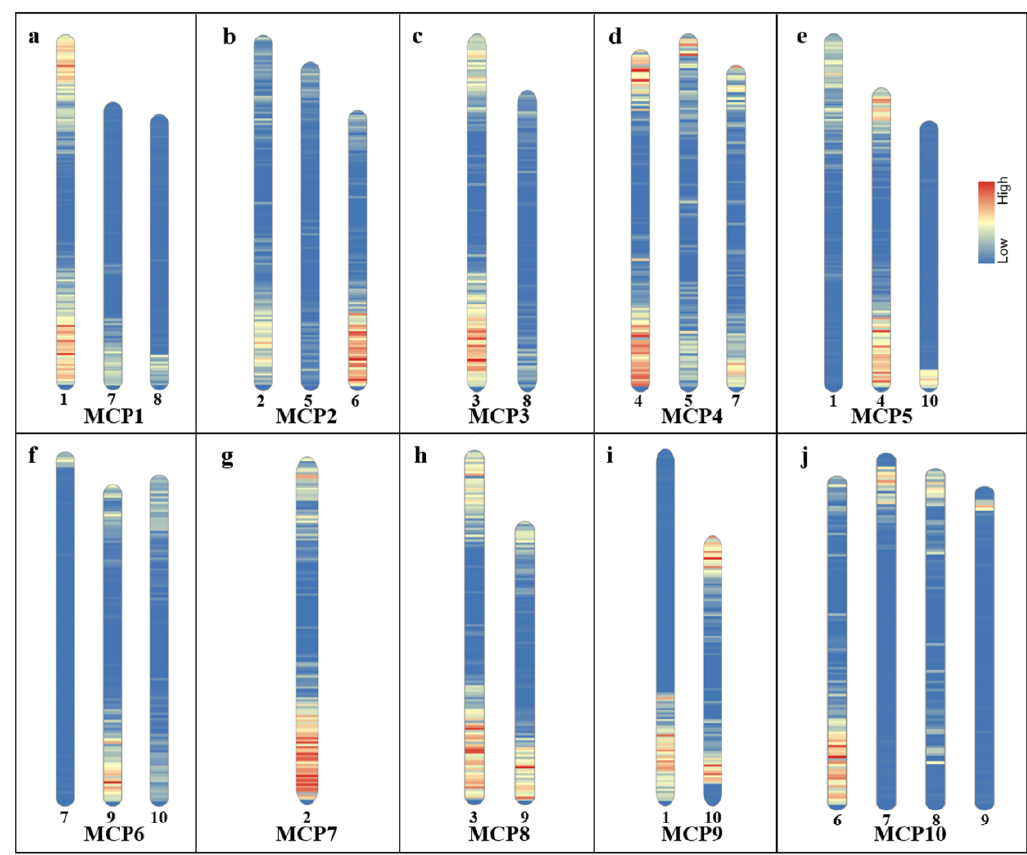
Figure 1. Maize CP sequences ’ distribution on sorghum chromosomes. Arabic numerals indicate the chromosome of sorghum; ( a – j ) indicate the MCP1-10 sequence distributions on sorghum chromosomes in each 500 kb window, respectively. Table 1. The number of maize CP sequences aligned to each of the sorghum chromosomes.